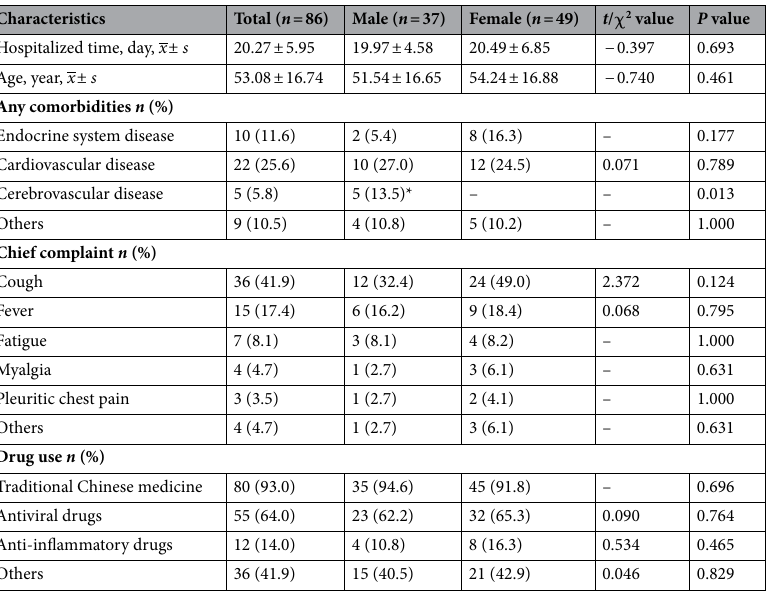
Table 1. Clinical characteristics of patients with moderate COVID-19. x ± s Average ± standard deviation. *Significant difference between the two groups, P <